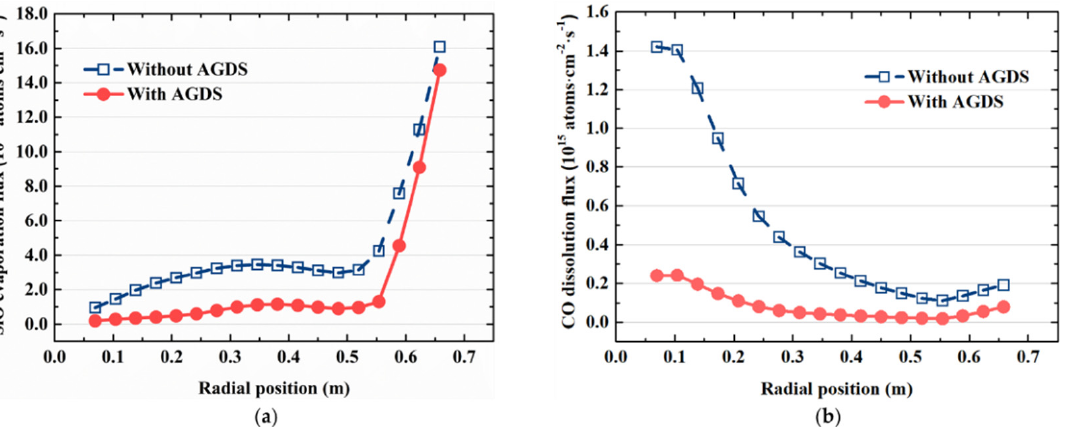
Figure 7. The concentration distributions of SiO and CO above the free surface at 50% crystalline fraction without ( a ) and with ( b ) AGDS.